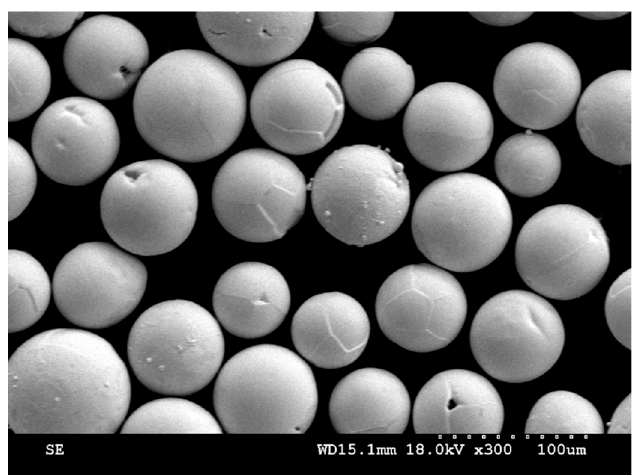
Figure 6. SEM image of the molybdenum powders with high granule density.